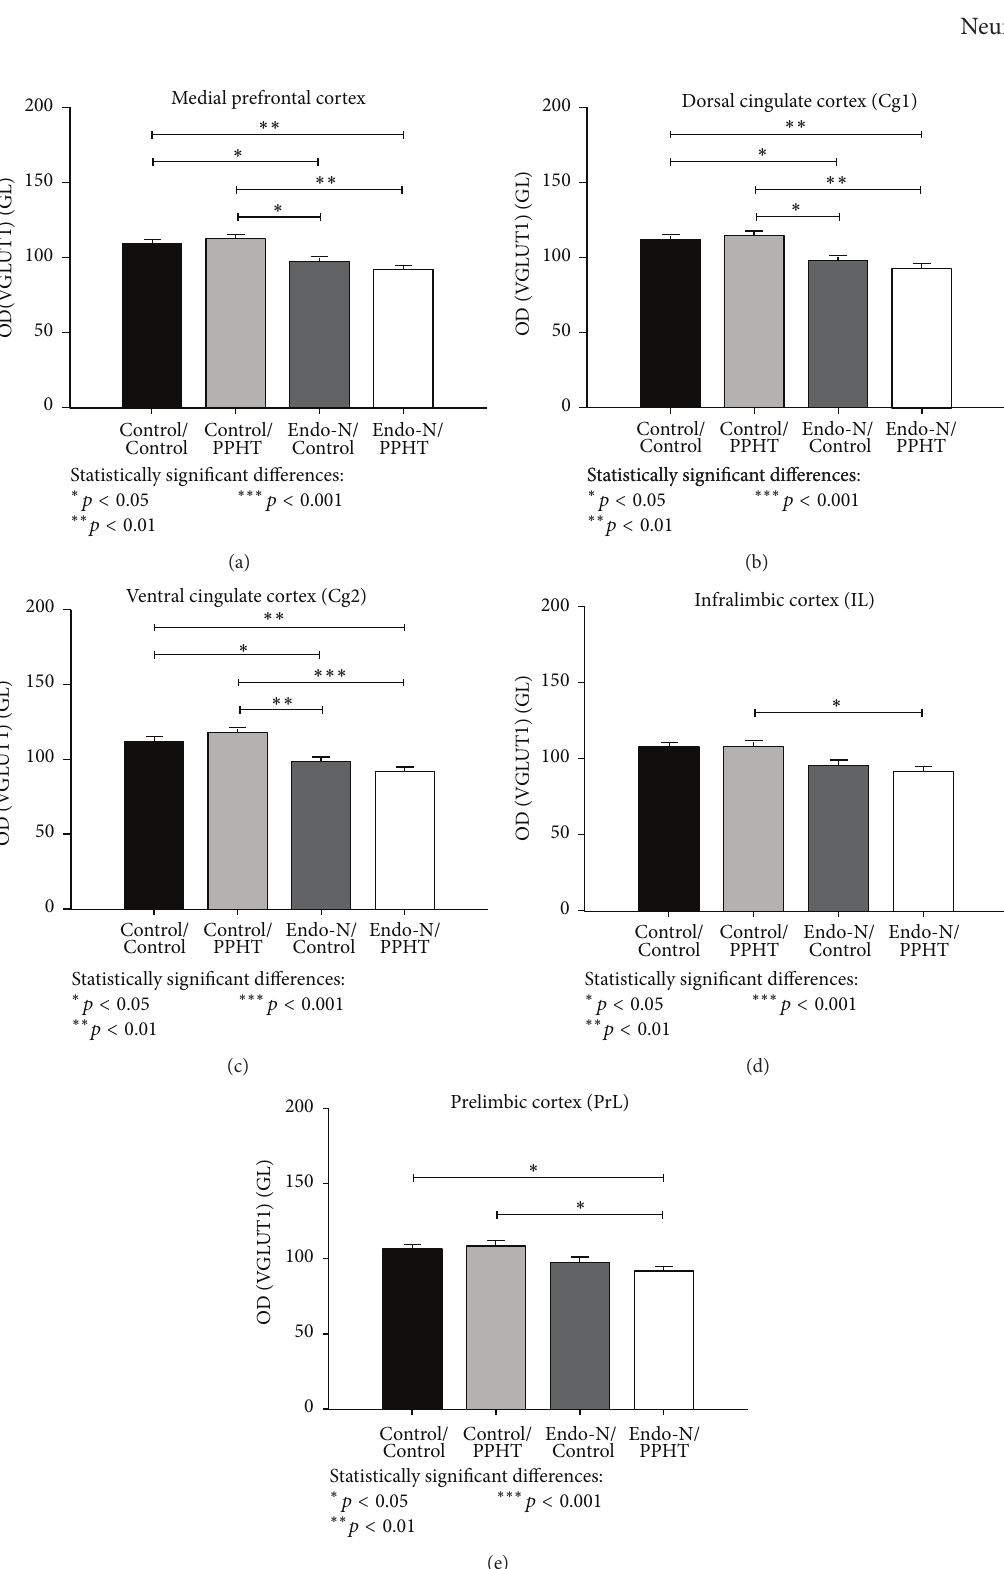
Figure 2: Graphs showing changes in the neuropil of VGLUT1 in the mPFC (a), dorsal cingulate (b), ventral cingulate (c), infralimbic (d), and prelimbic (e) cortices after Endo-N and/or PPHT treatments. Three sections per animal ( 𝑛 = 6 animals/group) were examined under bright-field illumination, homogeneously lighted, and digitalized using a CCD camera at 20x magnification. Grey levels were converted to optical densities (OD) using Image J software (NIH) (see Materials and Methods). Error bars represent SEM and asterisks in bars indicate statistically significant differences between groups after univariate repeated measures ANOVA followed by multiple pairwise comparisons with Bonferroni’s correction ( ∗ 𝑝 < 0.05 , ∗∗ 𝑝 < 0.01 , and ∗∗∗ 𝑝 < 0.001